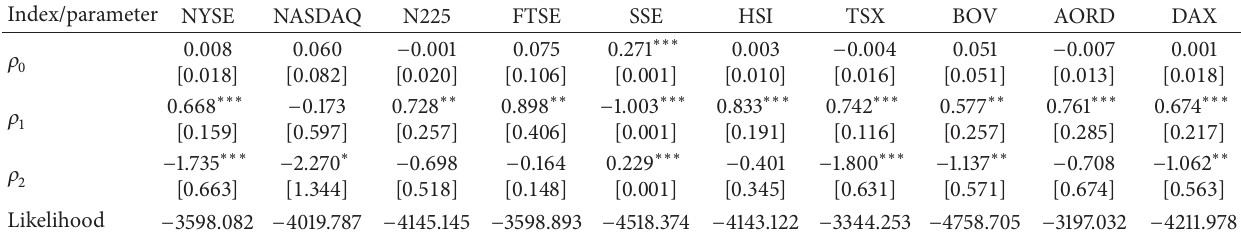
Table 4: Results of TVRA-GARCH-M model ( 𝑃 5 𝑡 ).